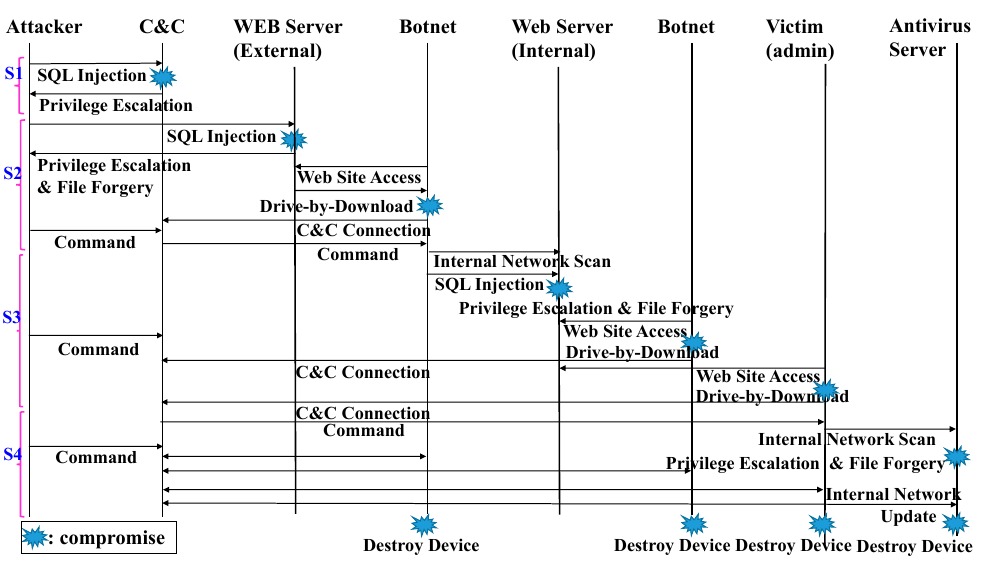
Figure 5. Procedure of advanced persistent threat.